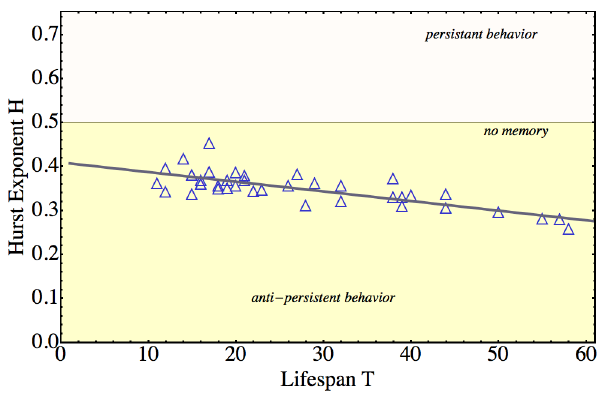
Figure 5. Hurst Exponents of the Failure Rate Kinetics of Long- term Repopulating HSCs. Plotted are the Hurst exponents (plot symbol: blue triangles; values vertical axis) of the failure rate kinetics of HSCs with lifespans w 10 and v 60 months (horizontal axis). Calcula- tions were performed using Algorithm 0 (compare Table S1 in Text S1). All exponents are v 0 : 5 , thus falling into the region of anti-persistent behavior (defined by Hurst values 0 ƒ H v 0 : 5 (light-yellow region)) and not into the region of persistent behavior (defined by 0 : 5 v H ƒ 1 (light- pink region (only displayed up to 0.7 to enhance visibility of the data))). Our previous results [8] that past values of an HSC’s repopulation kinetic predict future values, had suggested the hypothesis that Hurst exponents of the failure rates would either be greater, or less, than H ~ 0 : 5 . The value H ~ 0 : 5 is traditionally interpreted as ‘‘no memory’’ of past behavior in future behavior (horizontal line marked ‘‘no memory’’). The data shown then suggest that, mechanistically, anti- persistence plays a role in controlling clonal growth. The H values obtained from our experimental data were fitted to the line L ( T ) ~ 0 : 411 { 0 : 0023 T as a function of lifespan T (gray solid line through the data). Goodness-of-Fit was determined using the Akaike Information Criterion ( AIC ~{ 71 : 98 ). The parameter estimates